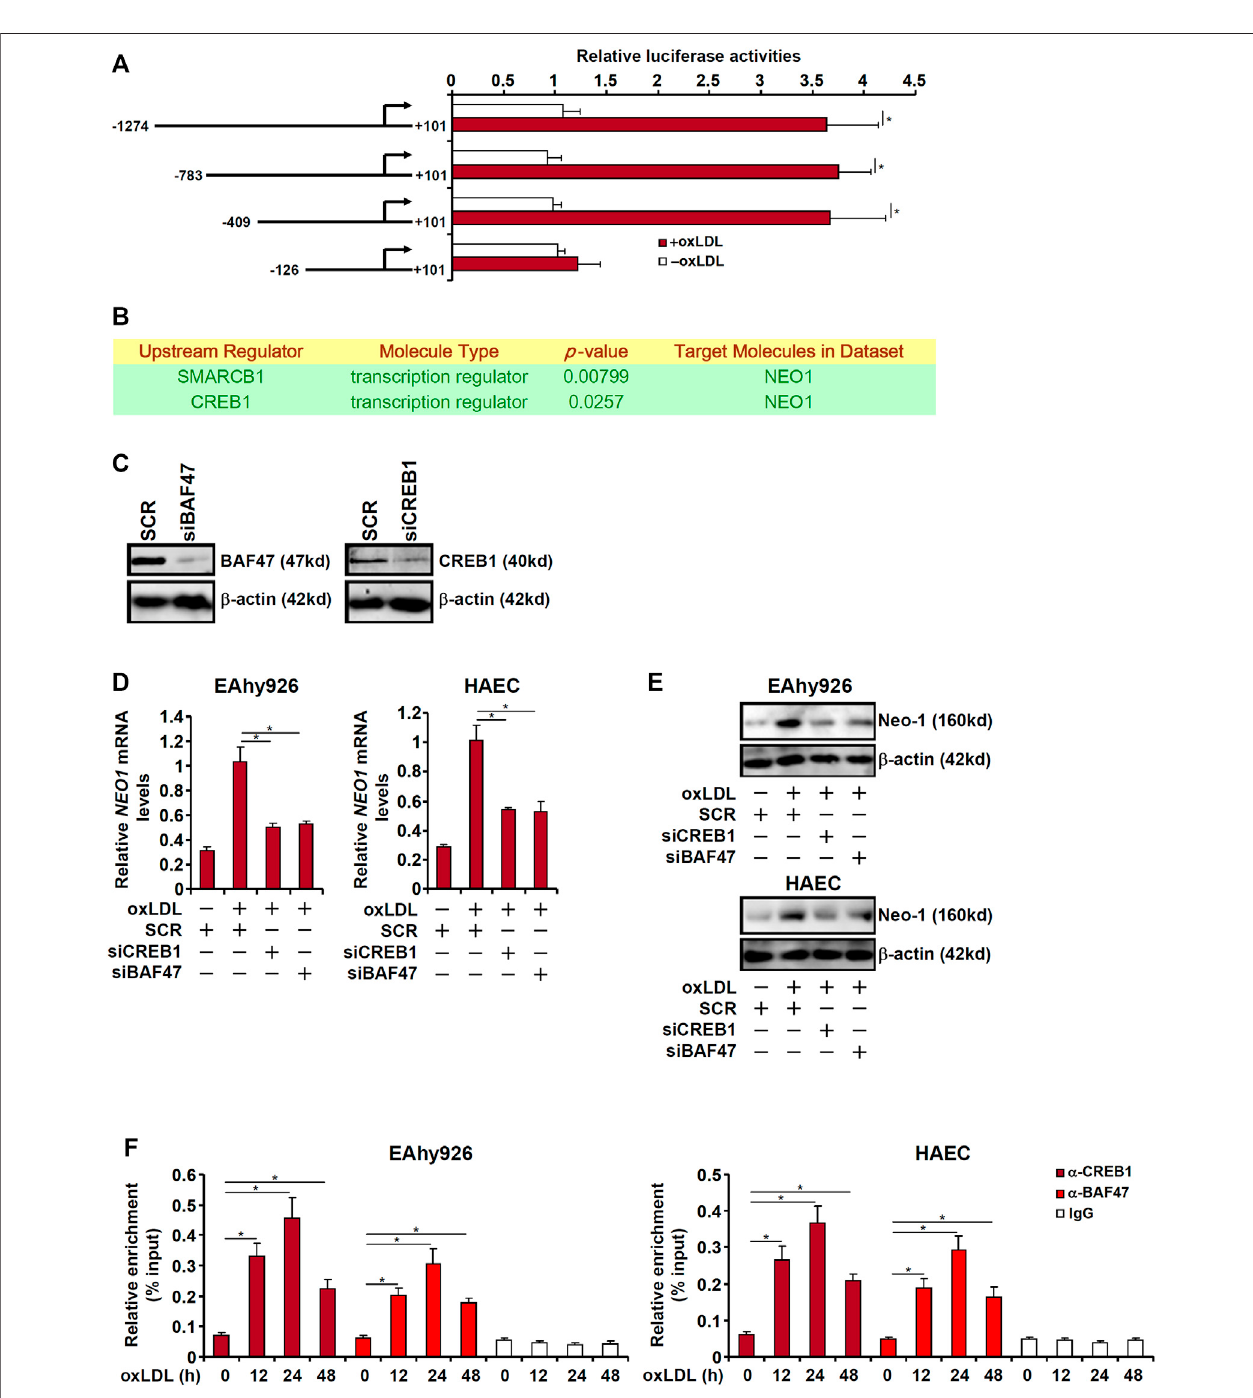
FIGURE 5 | CREB1 and BAF47 are essential for transcriptional activation of Neo-1 in endothelial cells. (A) Neo-1 promoter-luciferase constructs were transfected into EAhy926 cells followed by treatment with oxLDL (50 μ g/ml) for 24 h. Luciferase activities were normalized by protein concentration and GFP fl uorescence. (B) Ingenuity pathway analysis. (C) EAhy926 cells were transfected with indicated siRNAs. Knockdown ef fi ciencies were examined by Western. (D,E) EAhy926 cells and HAECs weretransfected withindicatedsiRNAs followed by treatment withoxLDL (50 μ g/ml) for 24 h. Neo-1 expression wasexaminedby qPCR and Western. (F) EAhy926 cells and HAECs were treated with oxLDL (50 μ g/ml) and harvested at indicated time points. ChIP assays were performed with anti-CREB1, anti-BAF47, or IgG.